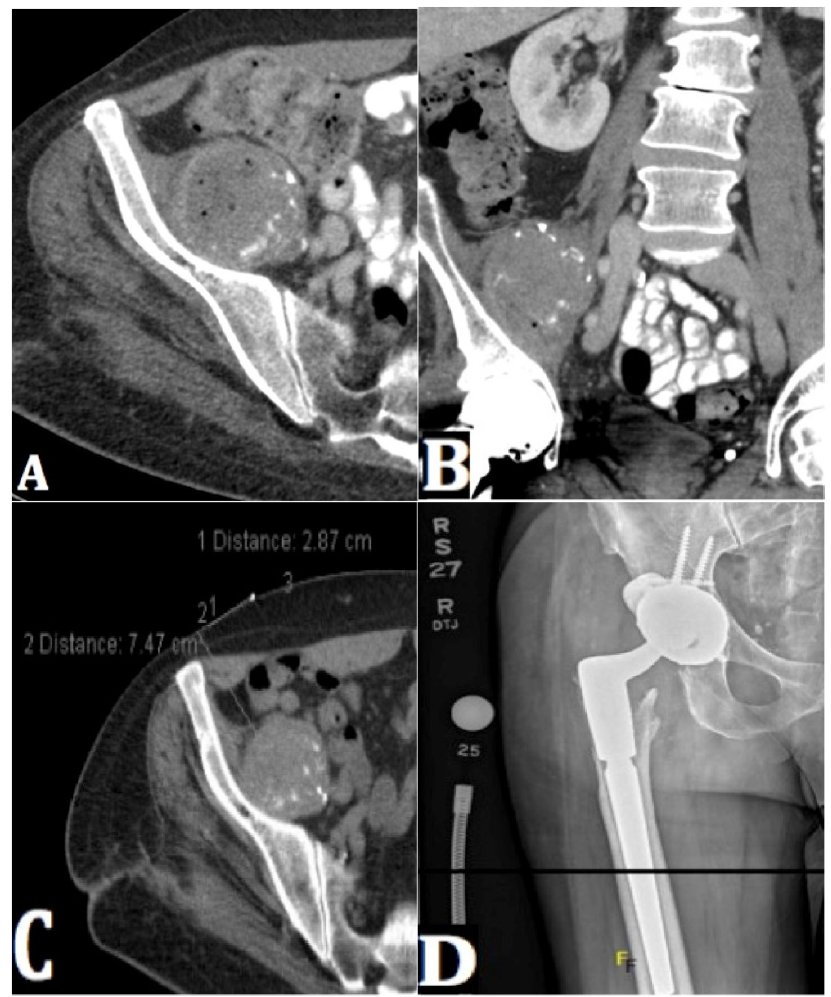
Figure 3. (A) An axial CT pelvis shows fluid distension with intermittent gas in the right iliacus muscle, also containing scattered calcifications. (B) A coronal CT pelvis image shows fluid distension with intermittent gas in the right iliacus muscle, also containing scattered calcifications. This was biopsy and aspirate proven to be consistent with infected hematoma. Notably, the patient was on Coumadin following his initial primary THA operation. (C) A repeat axial CT pelvis image reveals a persistent right iliacus abscess. (D) An AP radiograph of the right hip shows a right hip revision arthroplasty with hardware intact and no evidence of loosening at four months